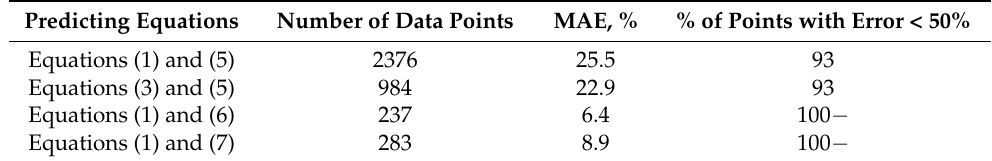
Table 1. The evaluation of correlations for heat